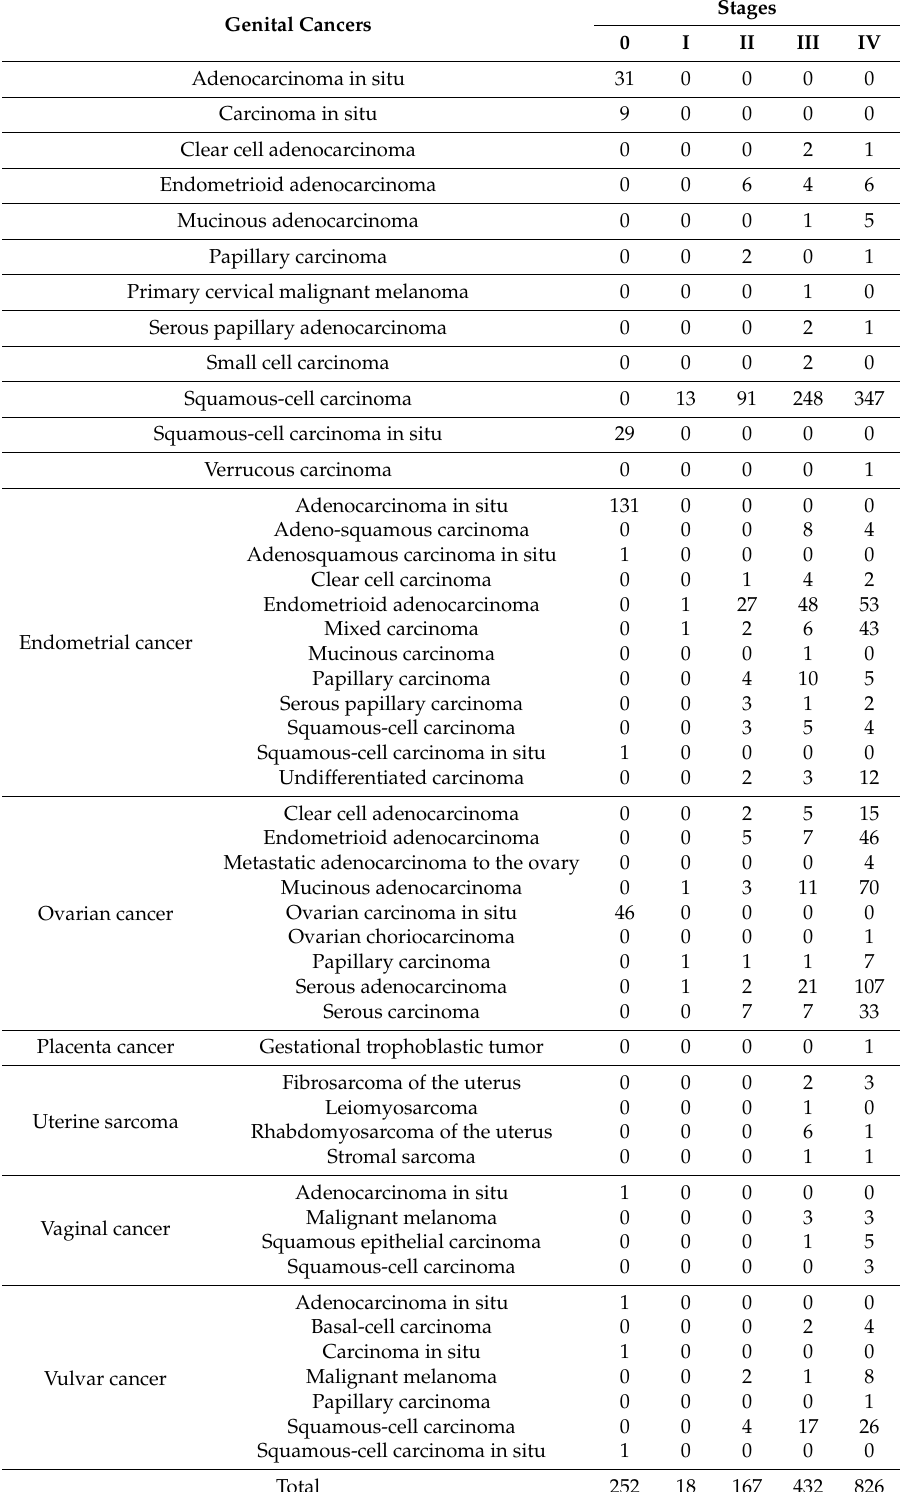
Table A2. Histopathological staging for all female genital